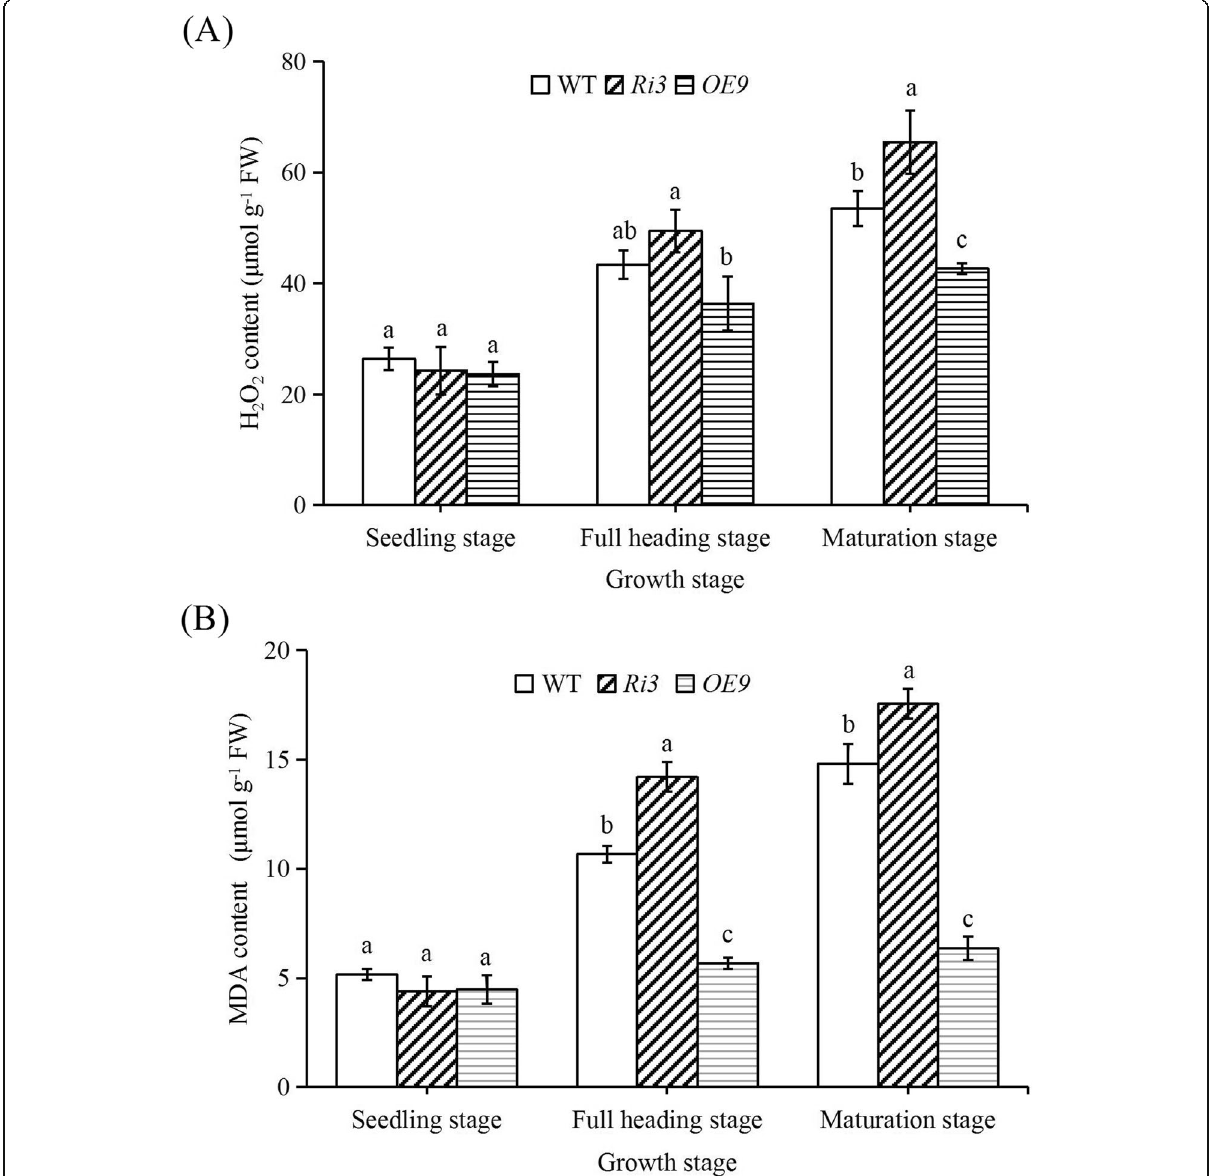
Fig. 4 Differences in reactive oxygen metabolism in wild-type and transgenic lines at different growth stages. a H 2 O 2 content. b MDA content. The seedling, full heading and maturation stages of rice were grown to 14d, 60d, and 90d after sowing, respectively. The penultimate leaves were selected at seedling stage, and sword leaves are selected for the determination of H 2 O 2 and MDA content at full heading and maturation stages. FW, fresh weight. Values are means±SEM, n = 5. Significant differences ( P < 0.05) are denoted by different lowercase